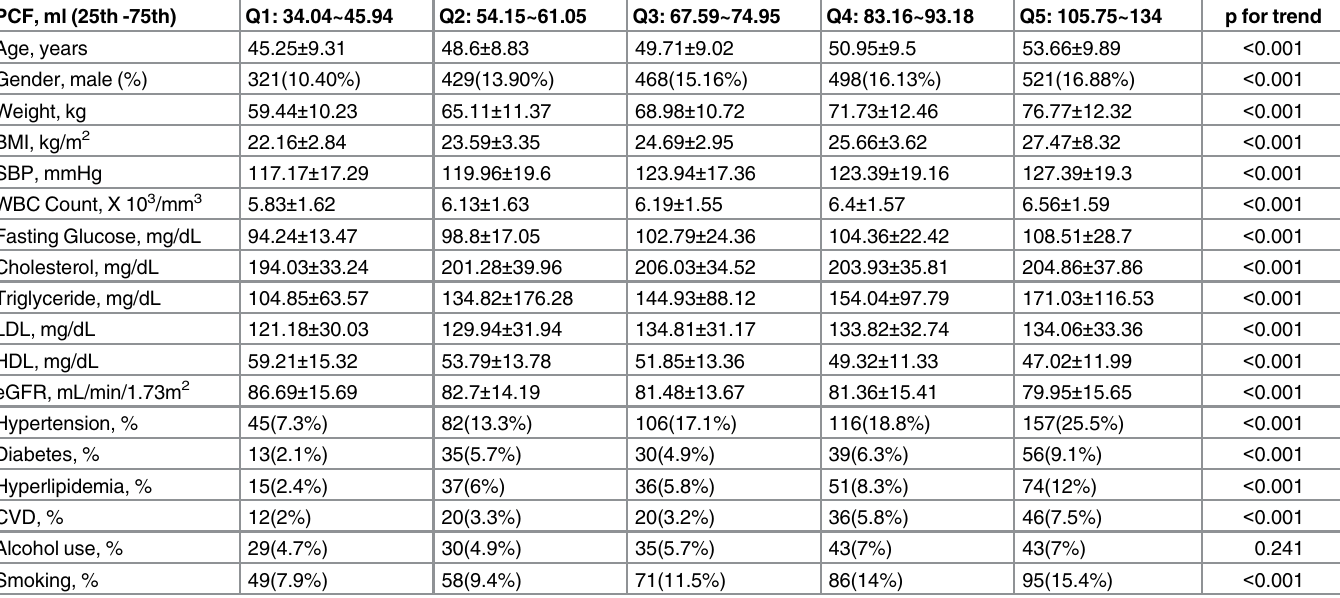
Table 1. Baseline demographic data of all study subjects based on visceral adiposity (either PCF or TAT) stratification in current study.